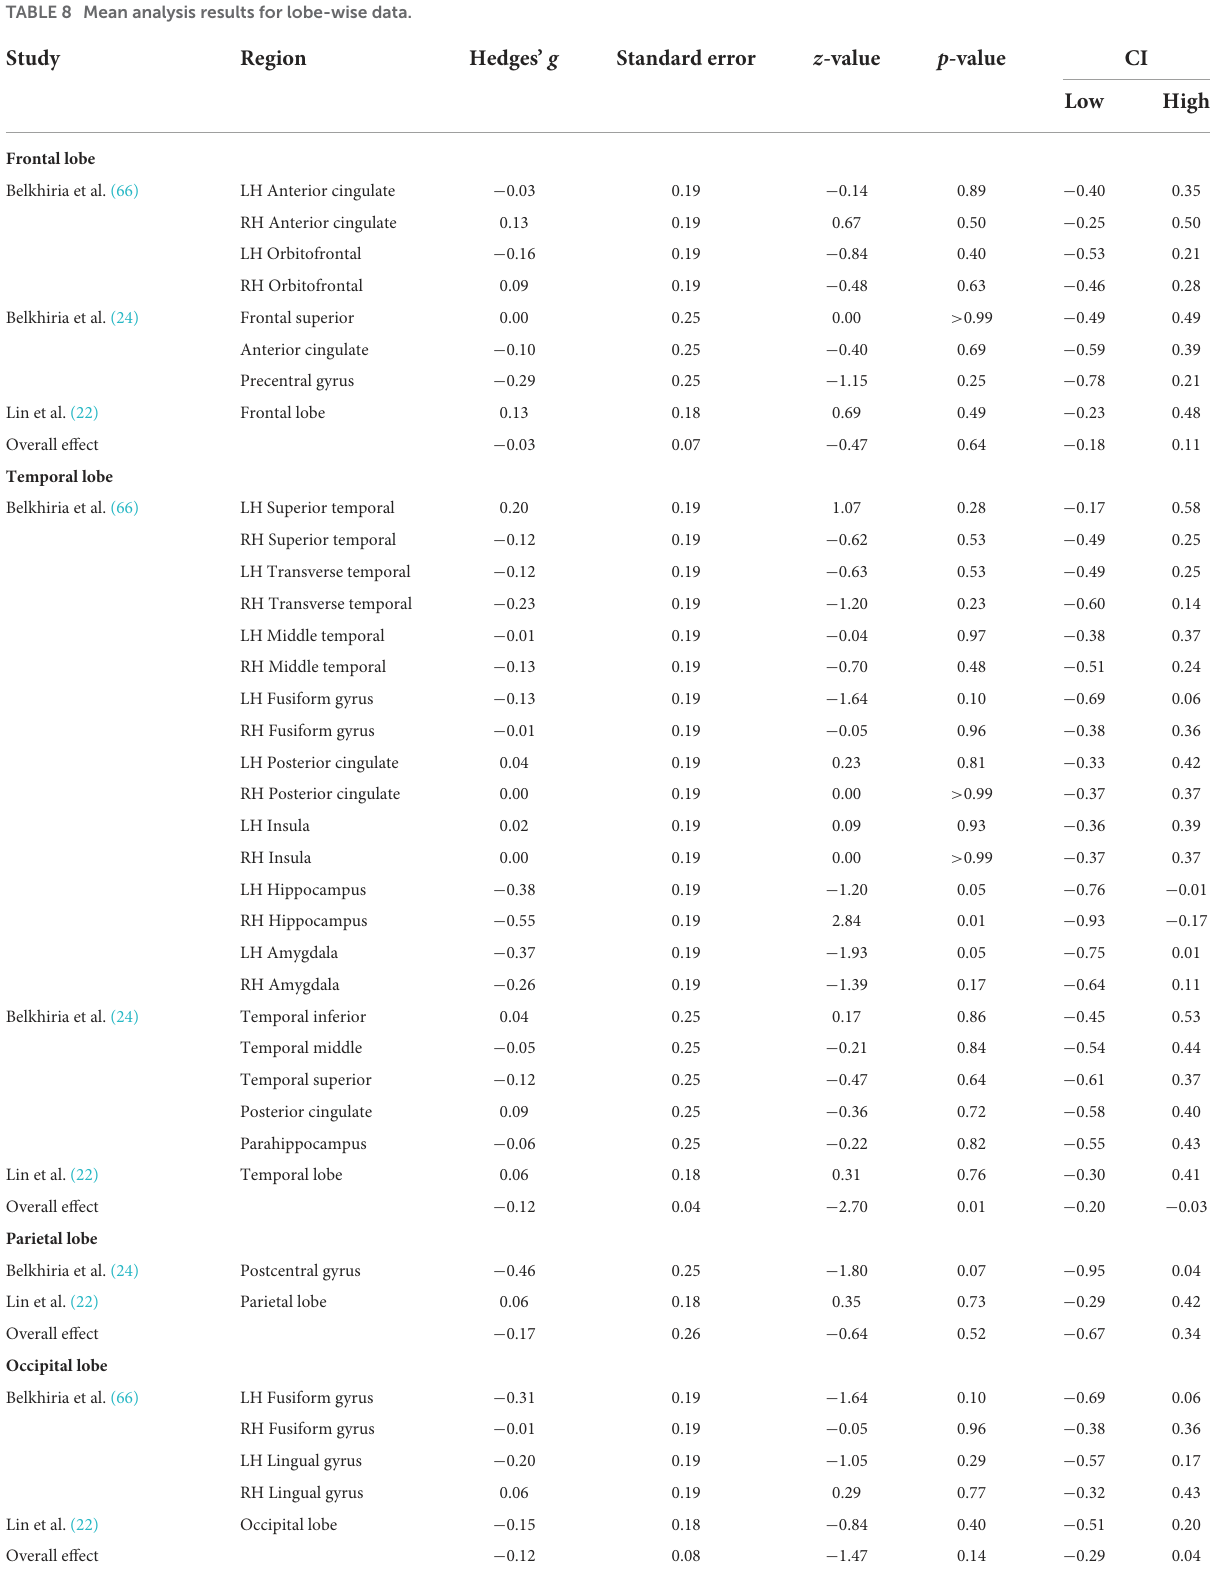
TABLE 8 Mean analysis results for lobe-wise